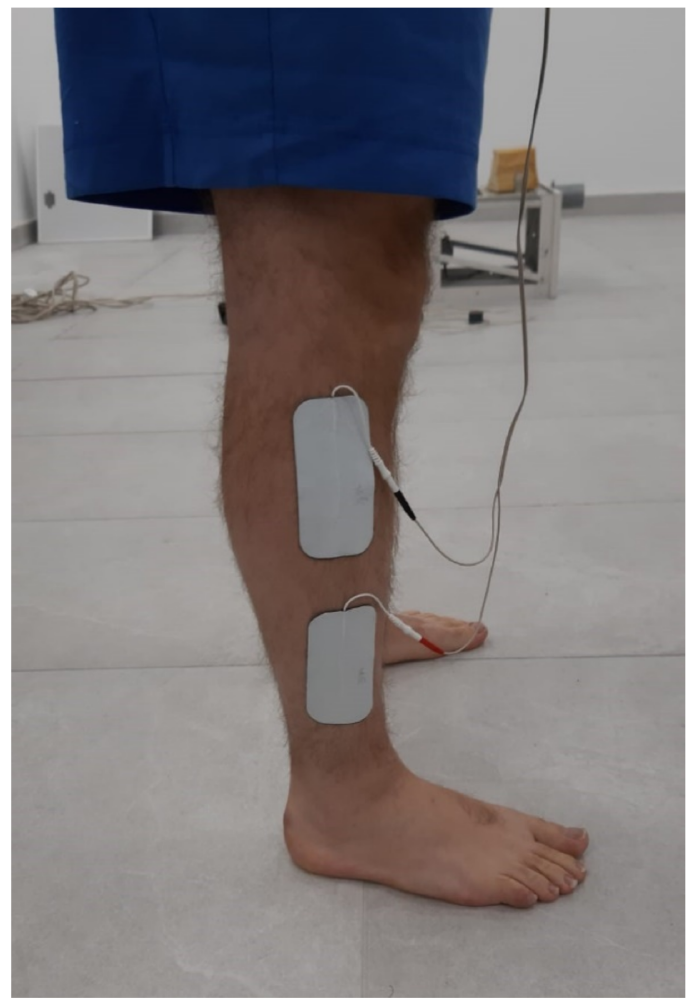
Figure 1. Electrodes’